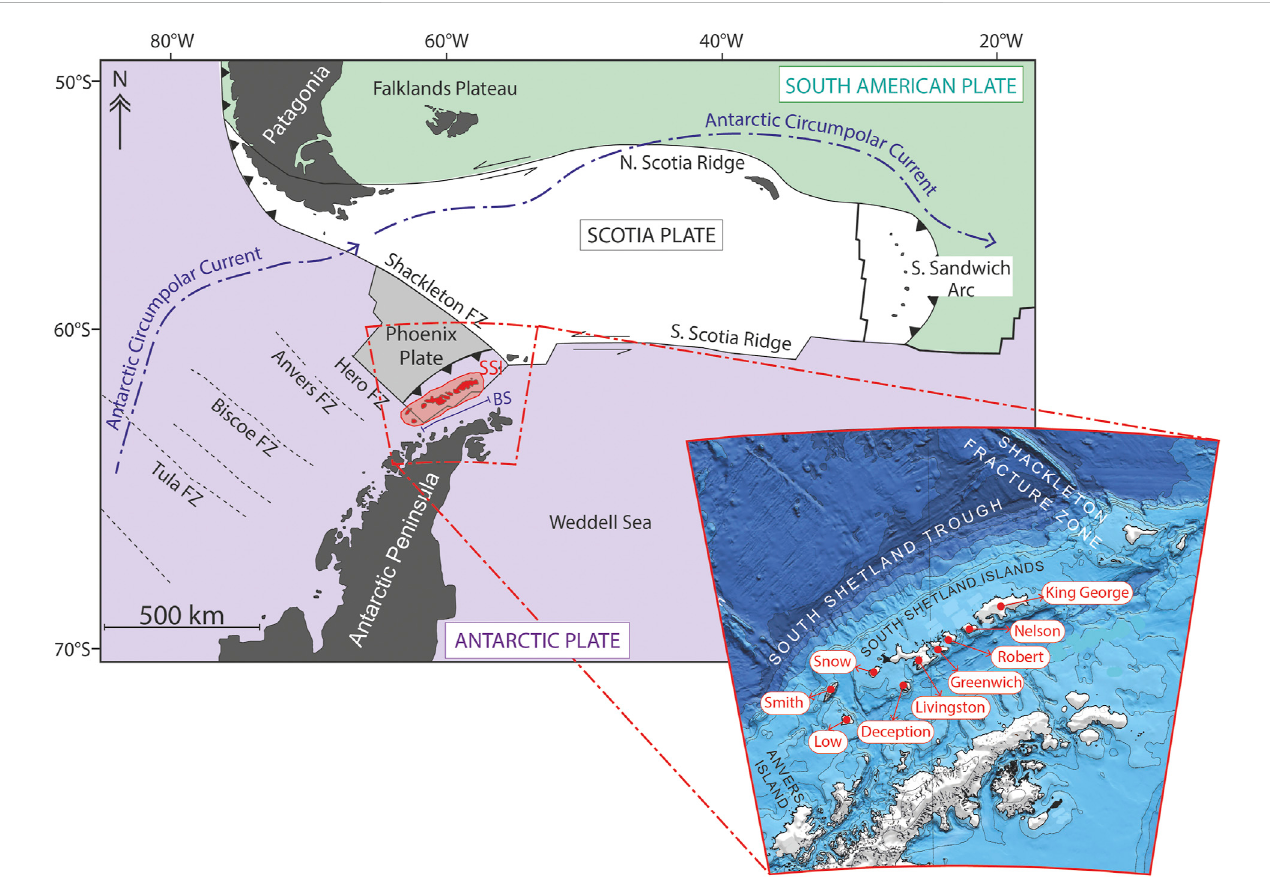
FIGURE 1 Tectonic con fi guration of the region encompassing the Scotia Plate, Patagonia and Antarctic Peninsula and showing the location of the South Shetland Islands and the Brans fi eld Strait. BS: Brans fi eld Strait. SSI: South Shetland Islands. Red box in inset fi gure shows the location of the archipelago and its main